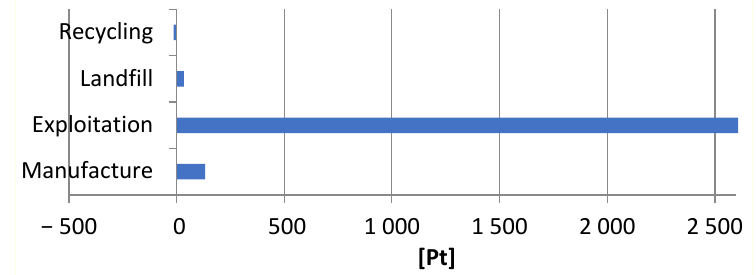
Figure 8. The results of grouping and weighing the environmental consequences occurring at individual stages of the life cycle of the research object.